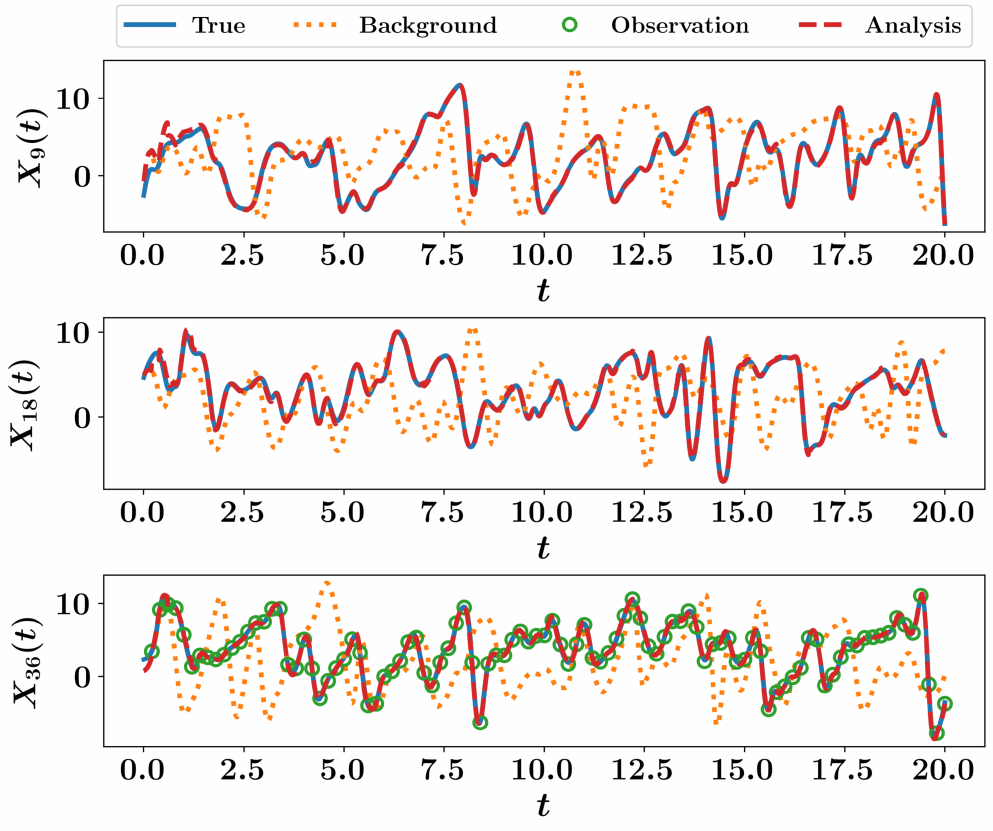
Figure 7. EKF results for the Lorenz 96 system. The trajectories of X 9 , X 18 , and X 36 are